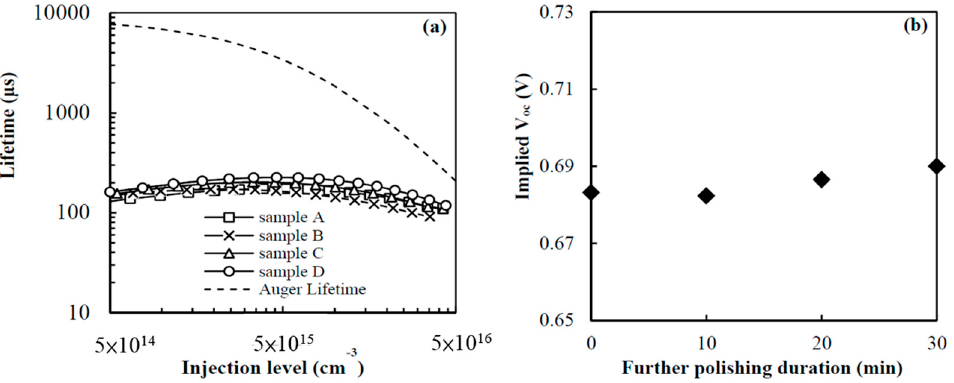
Figure 3. ( a ) Effective lifetime as a function of injection level; ( b ) Implied V oc for the Al 2 O 3 films with different rear-side surface morphologies.